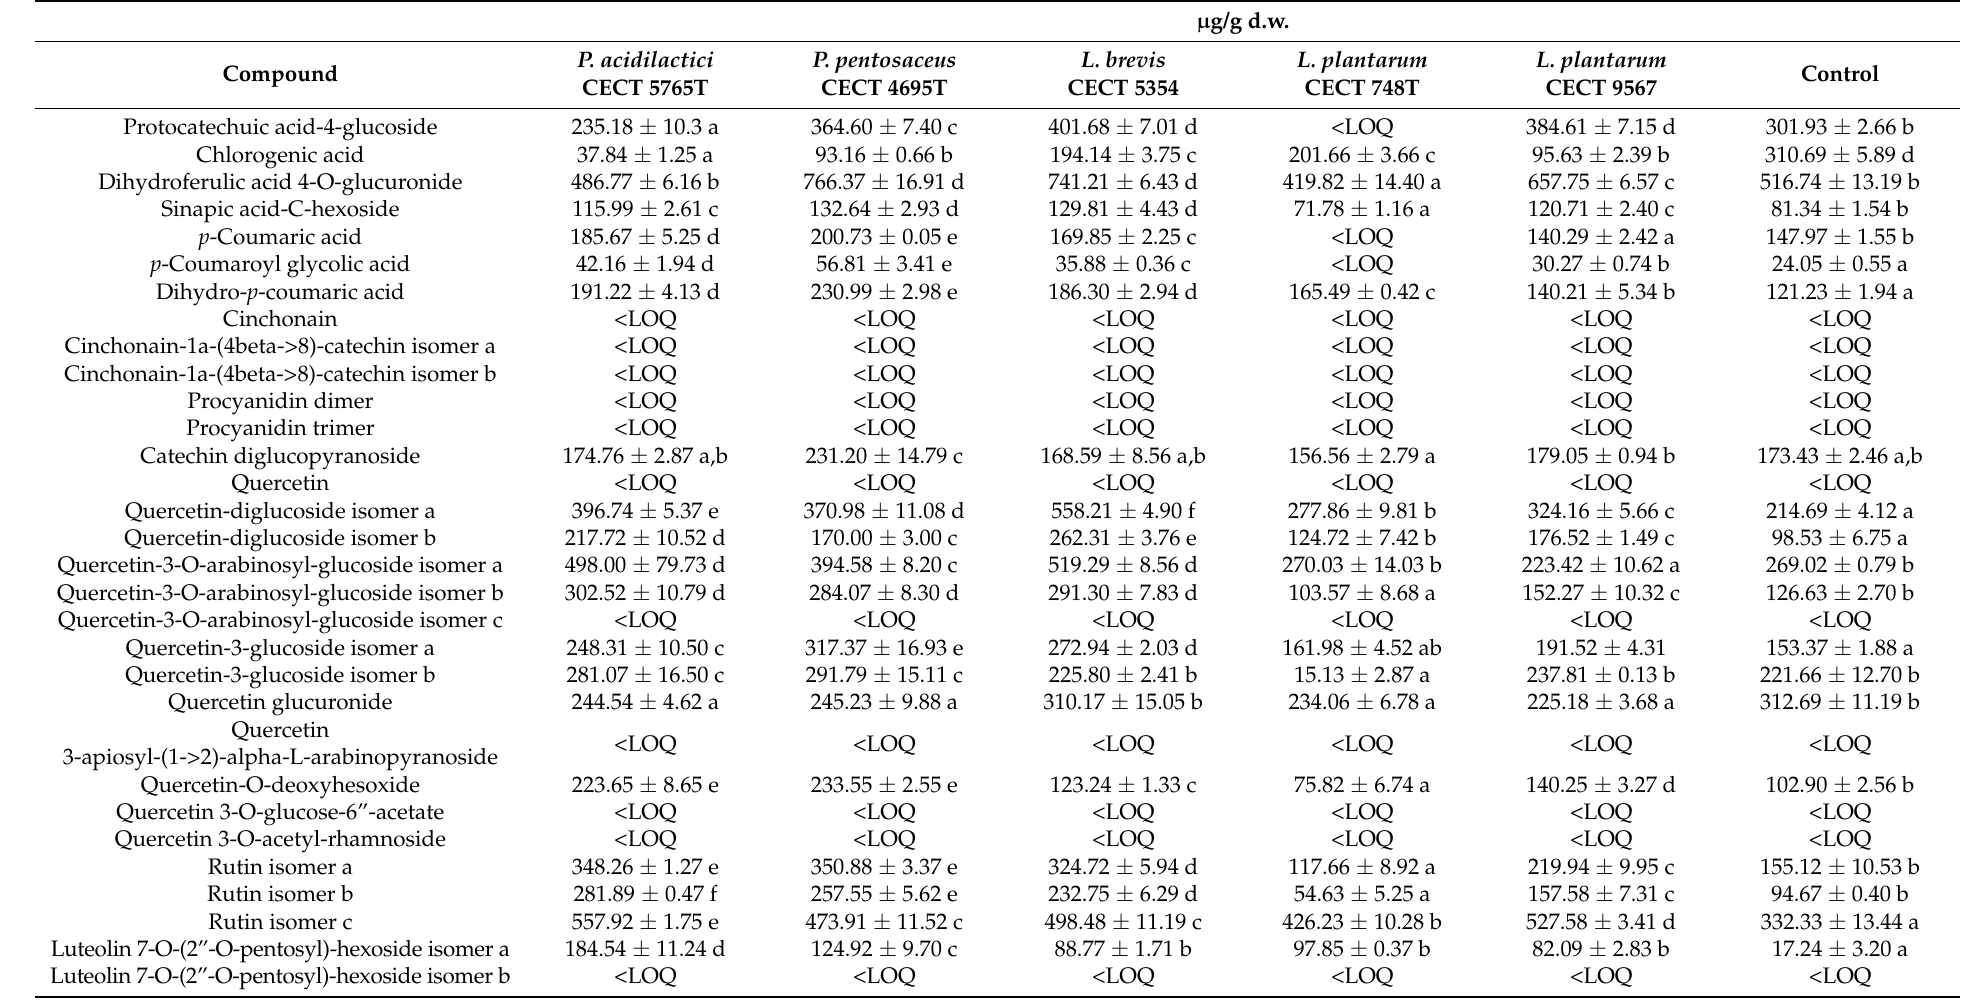
Table 3. Phenolic compounds quantified by HPLC-ESI-TOF-MS in the fermented avocado leaves and a control. Results are expressed as average ± standard